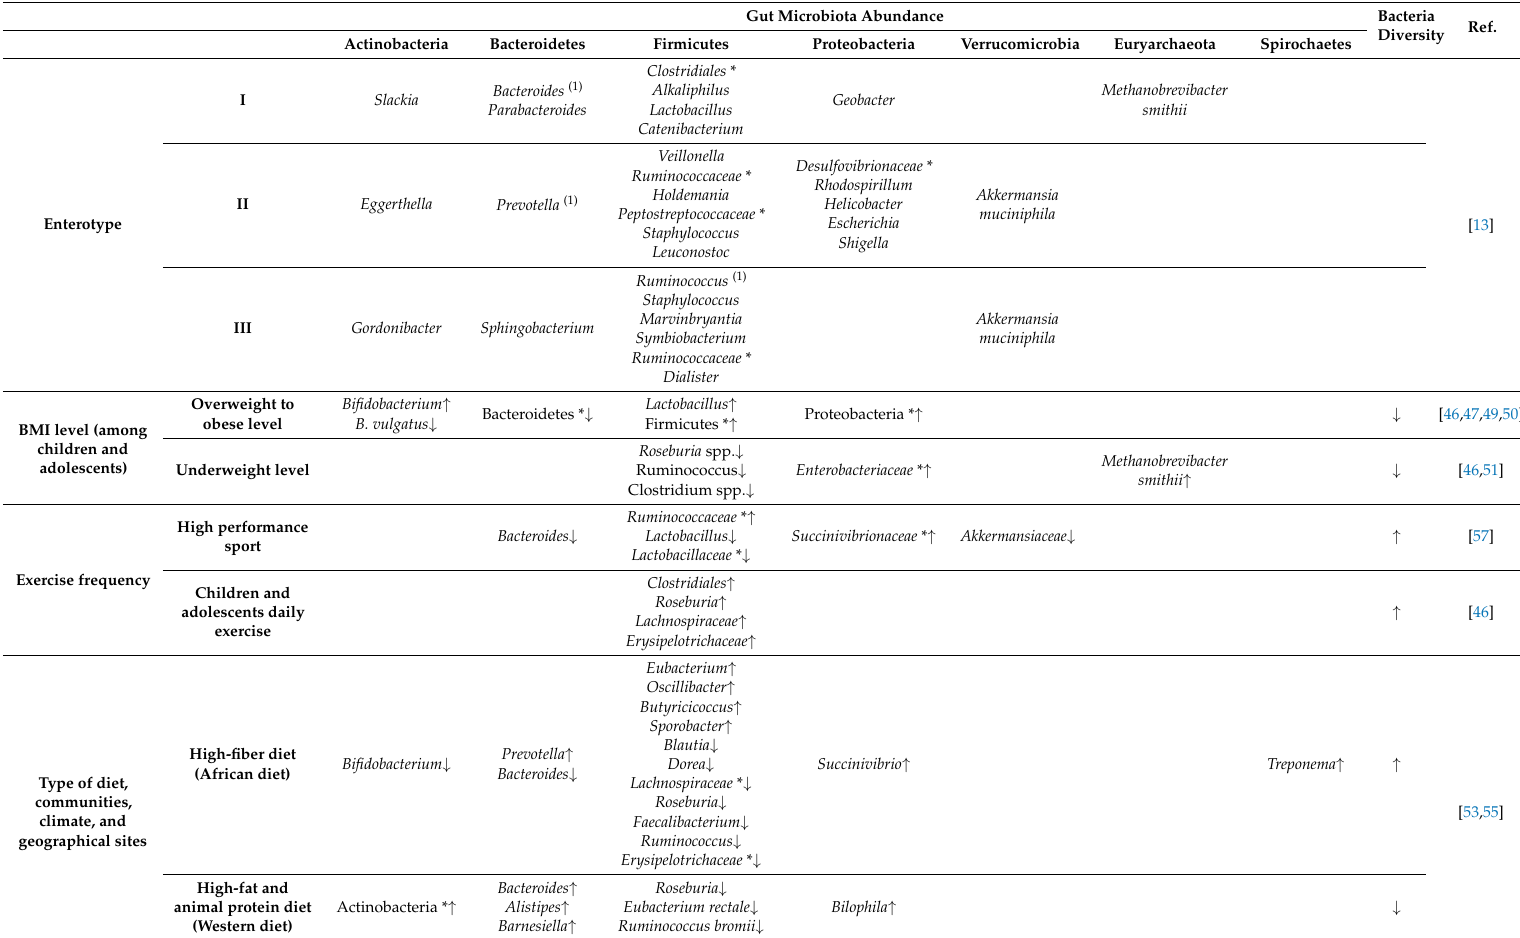
Table 2. Microbiota variations between